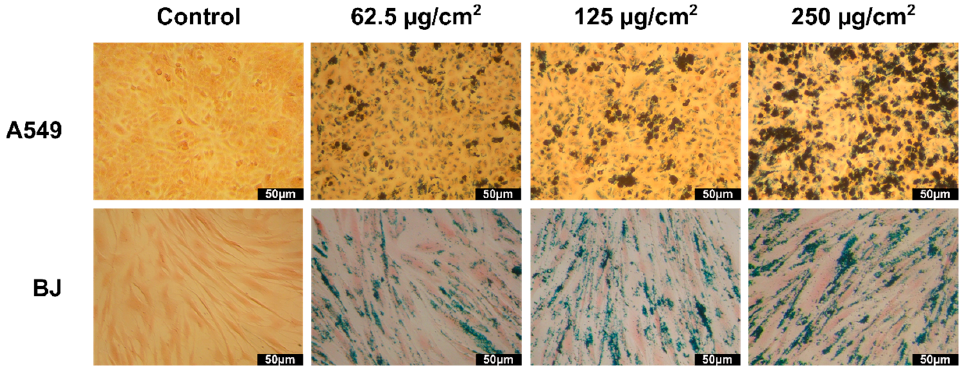
Figure 8. Microscopic images of A549 ( upper panels) and BJ ( lower panels) cells incubated with 62.5, 125, and 250 μ g/cm 2 ZnF02. Nanoparticles were stained with Prussian Blue.